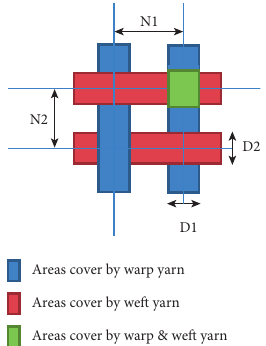
Figure 1: Interlacement of the warp and weft